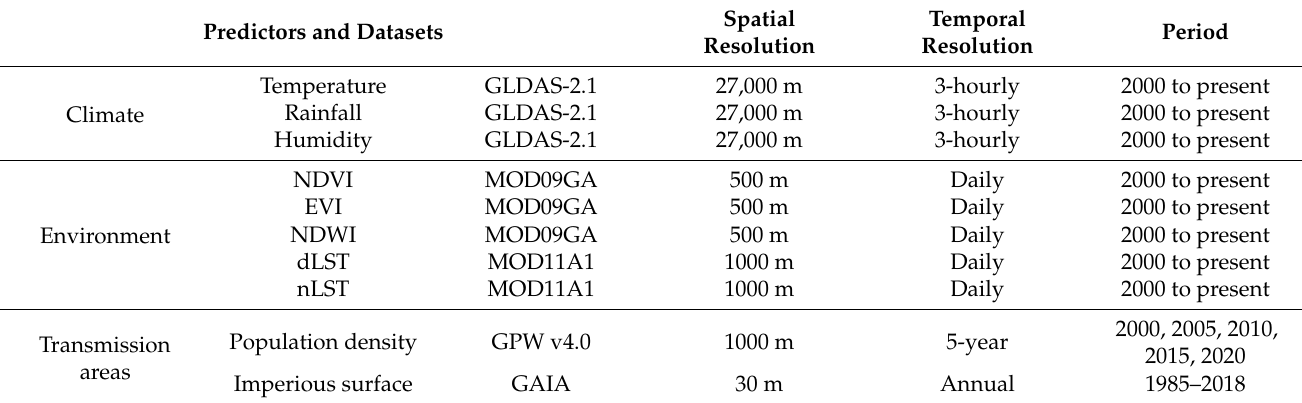
Table 1. The representative ready-to-use products in GEE platform can be used to define the predom- inant transmission area of dengue fever and identify dengue